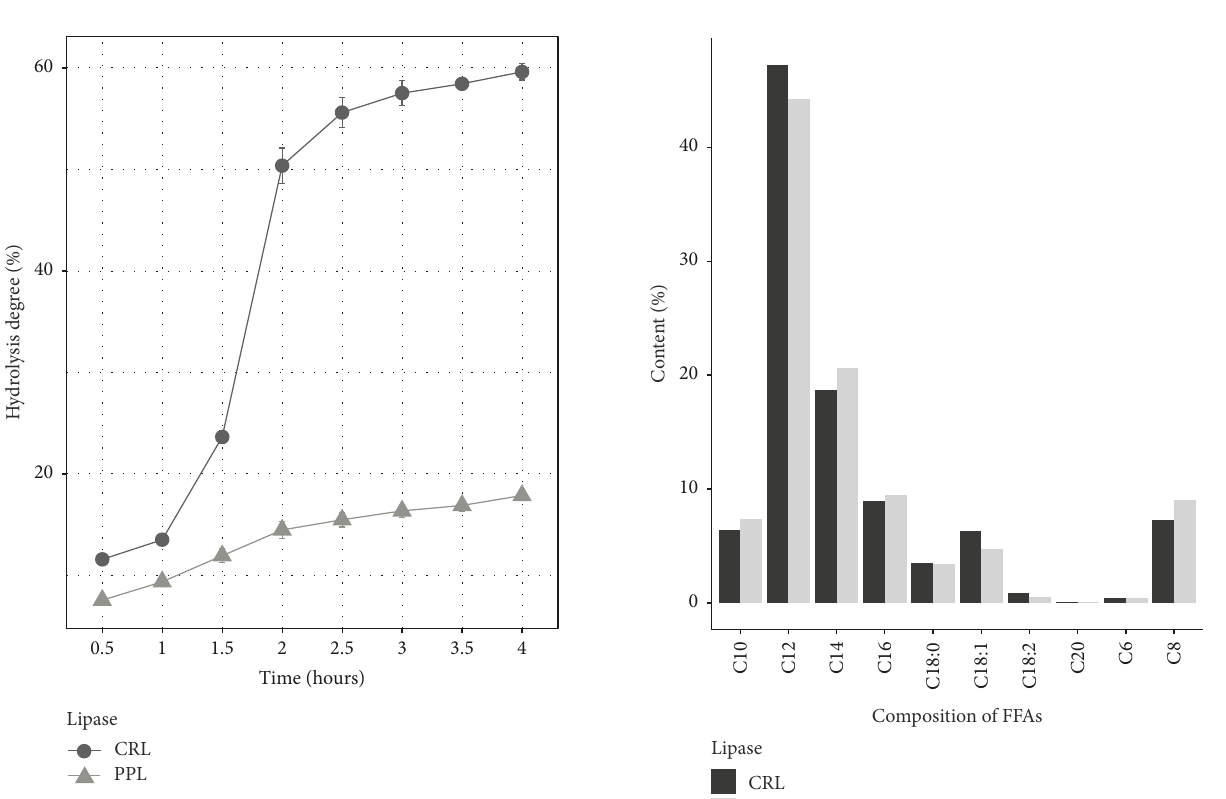
Figure 6: Hydrolysis degree at different time course.